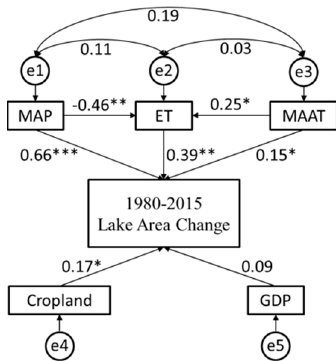
Figure 8. Structural model and path coefficient. Arrows show the effect path and direction. Numbers adjacent to arrows are path coefficients, ( β ). The path coefficients ( β ) characterize the extent of the effect of the examined variable on the lake changes, while the larger value indicates a strong positive or negative effect. P represents a significant level. * represents p-value < 0.1, ** represents p-value < 0.05, and *** represents p-value < 0.01. MAP denotes the mean annual precipitation, MAAT represents the mean annual air temperature, ET represents the evapotranspiration, and GDP represents the gross domestic product. The “e” represents the error (residual term) of path analysis of observed variables in the structural model. The numbers on the arrows are the values of the standardized regression weights of the model.